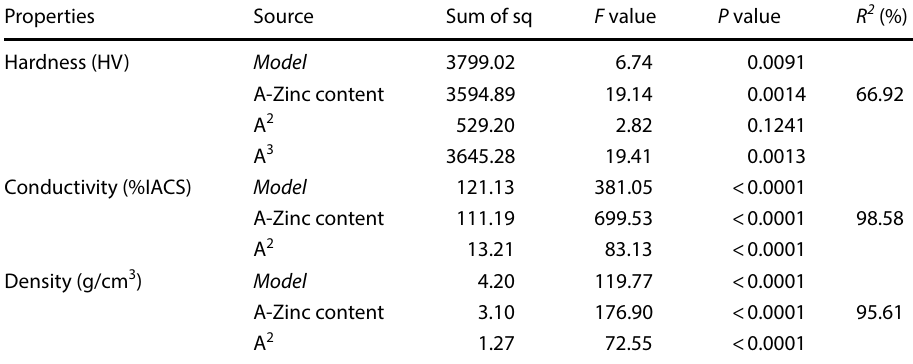
Table 1 Statistical data of the experimental results